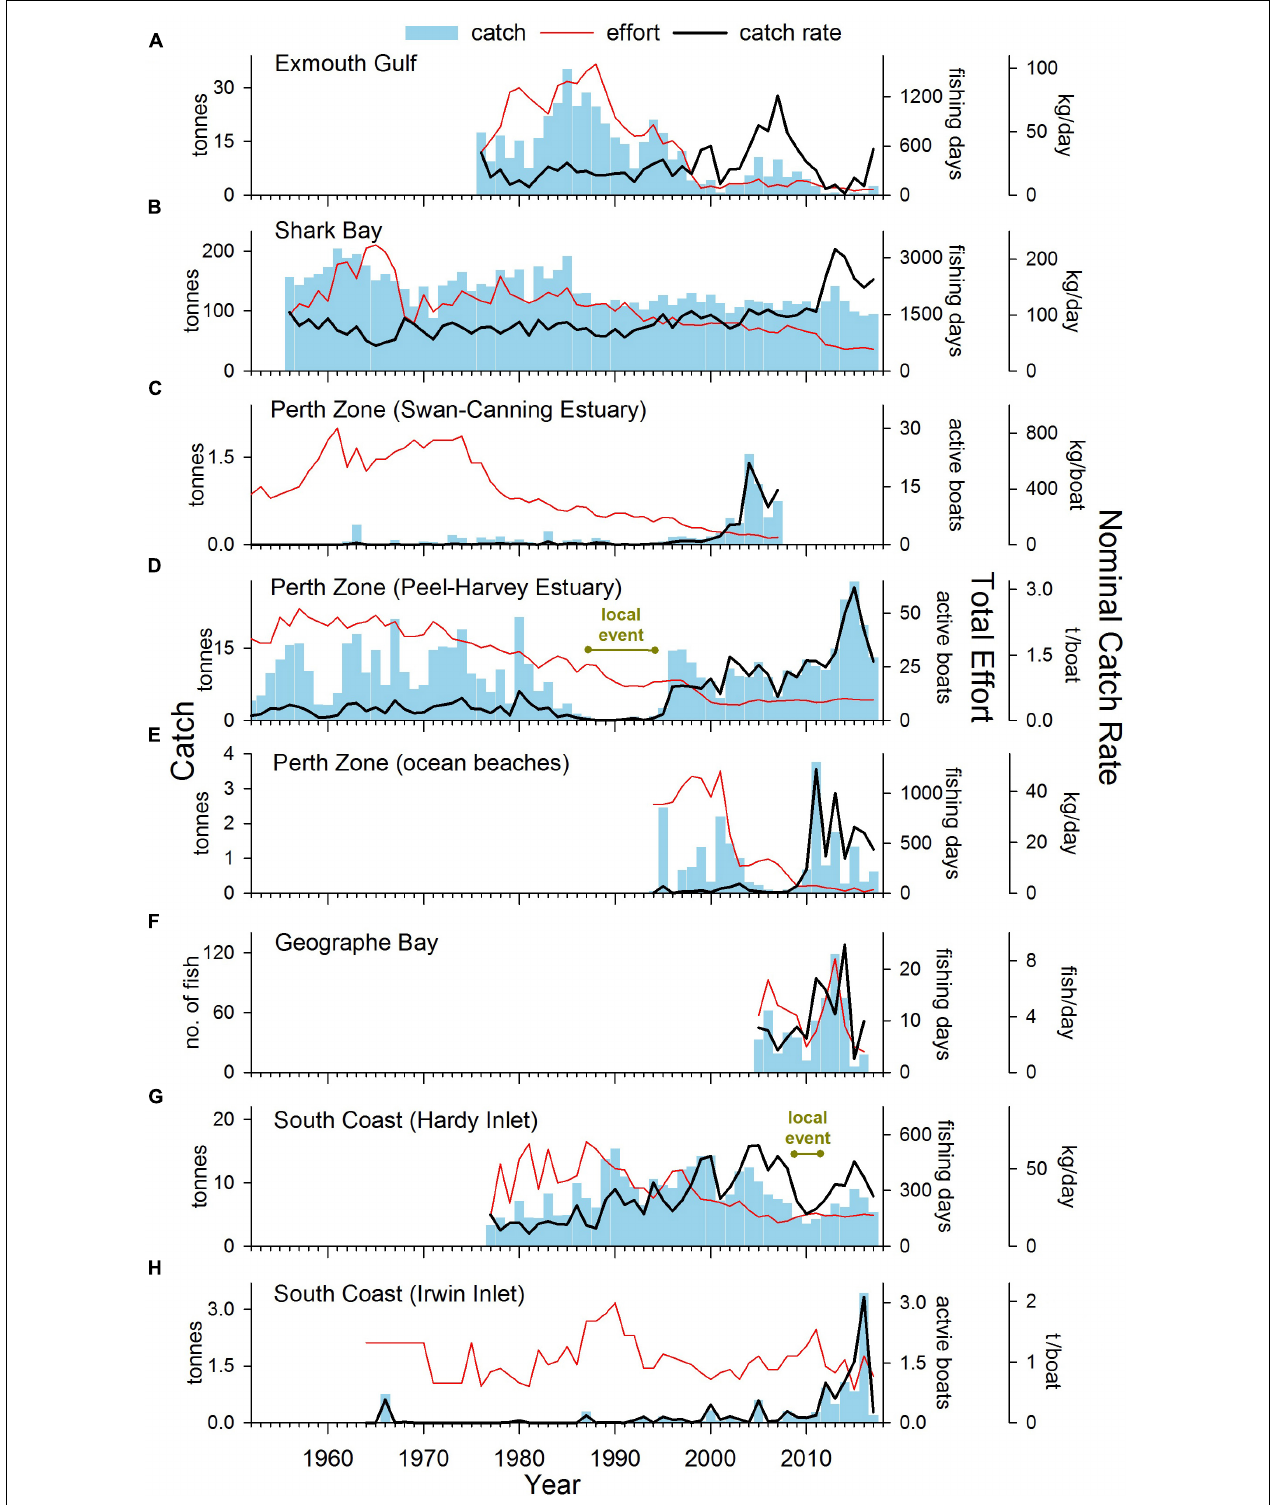
FIGURE 4 | Total annual catch, effort, and nominal catch rates of S. schomburgkii for commercial fisheries in (A) Exmouth Gulf, (B) Shark Bay, (C) Perth Zone (Swan-Canning Estuary), (D) Perth Zone (Peel-Harvey Estuary), (E) Perth Zone (ocean beaches), (G) South Coast (Hardy Inlet) and (H) South Coast (Irwin Inlet), and (F) recorded by a recreational fisher on ocean beaches in Geographe Bay. “Year” refers to calendar years except for (E–G) which are fiscal years.